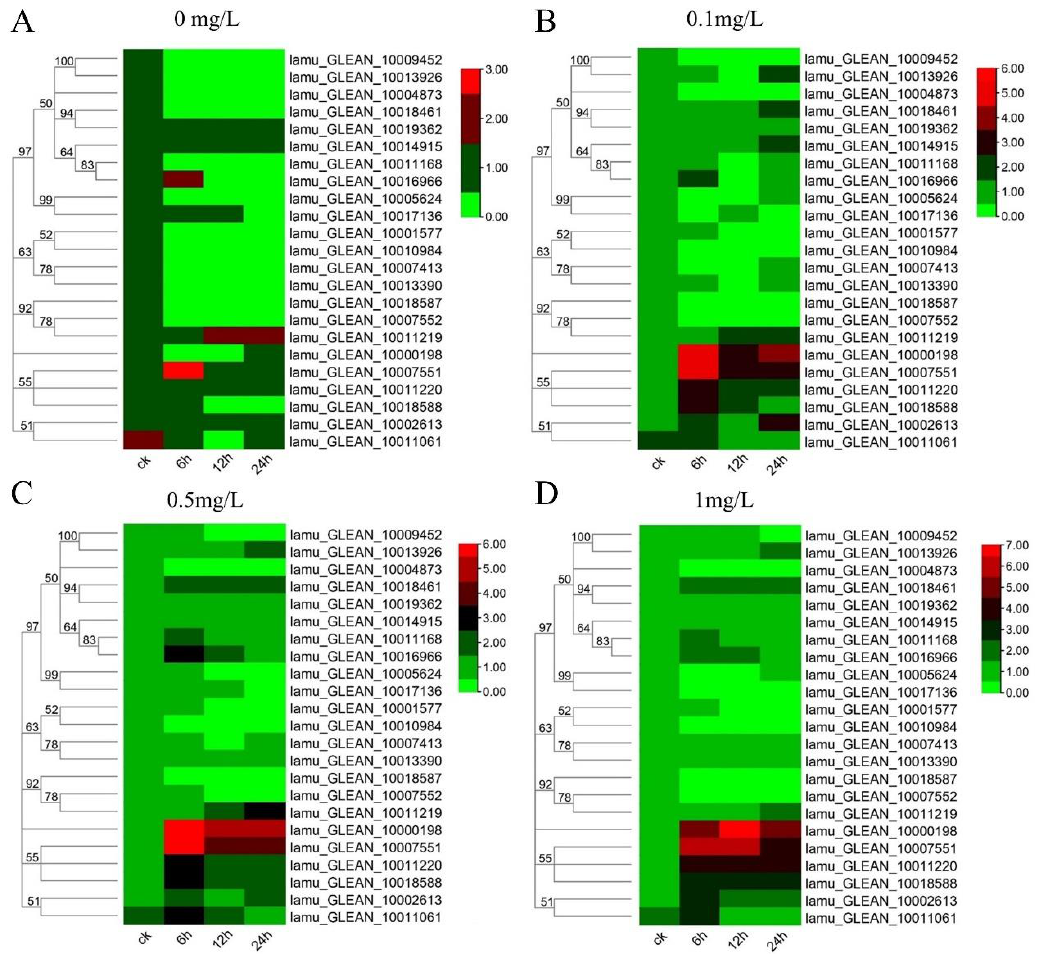
Figure 6. Heatmap of MoIAA gene expression level under 0 mg/L ( A ), 0.1 mg/L ( B ), 0.5mg/L ( C ), 1.0 mg/L ( D ) NAA treatment. The scale represents the logarithm of the value of gene expression.